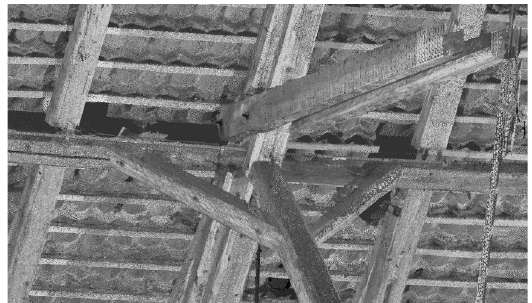
Figure 4. ReCap image of detail of the intermediate connection point among the Laves’ beam, tie beams and the supporting element with inclined braces.